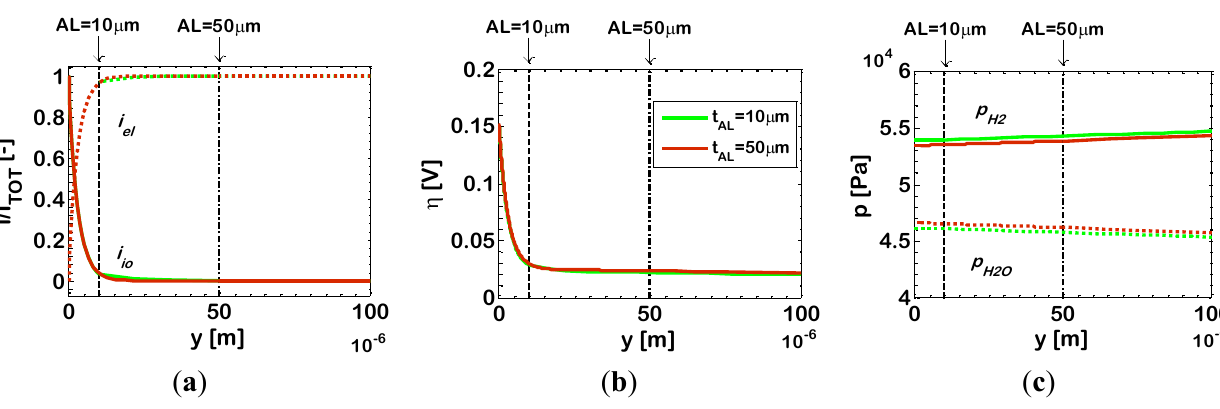
Figure 6. Bi-layered Ni-YSZ anodes at temperature T = 1073 K; Ni volumetric fraction in the AL ϕ = 0.55 (Case 2 ). Other data reported in Table 2. Varying parameter: el,AL d AL thicknesses: t = 10 µm and 50 µm. Simulated distributions along the electrode AL thickness of: ( a ) ionic ( i ) and electronic ( i ) currents; ( b ) overpotential (η); and ( c ) partial io el pressures of hydrogen ( p ) and water ( p H2 H2O